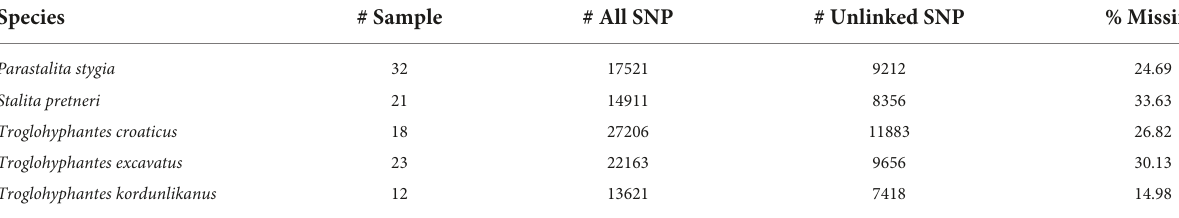
TABLE 1 Number of samples and single nucleotide polymorphisms (SNPs) per species after filtering steps. Species # Sample # All SNP # Unlinked SNP %